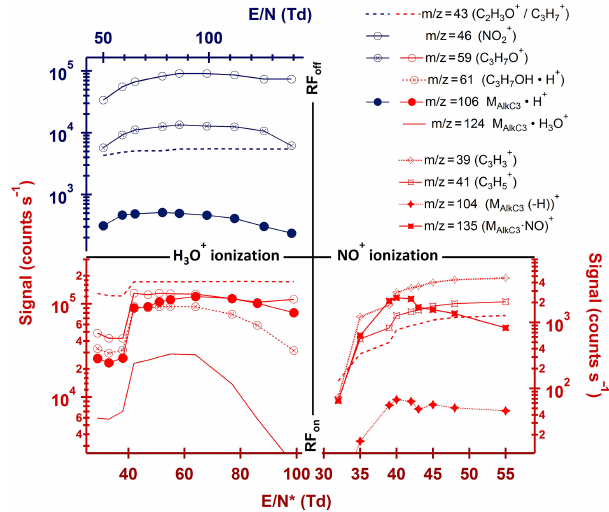
Figure 1. Typical ionizing species distribution as a function of the E/N ratio, in the two ionization modes with RF mode on and off. When the RF mode is on, E/N ∗ ratios were calculated taking into account only the contribution of the DC electric field while the ad- ditional input of the AC electric field remains difficult to estimate.